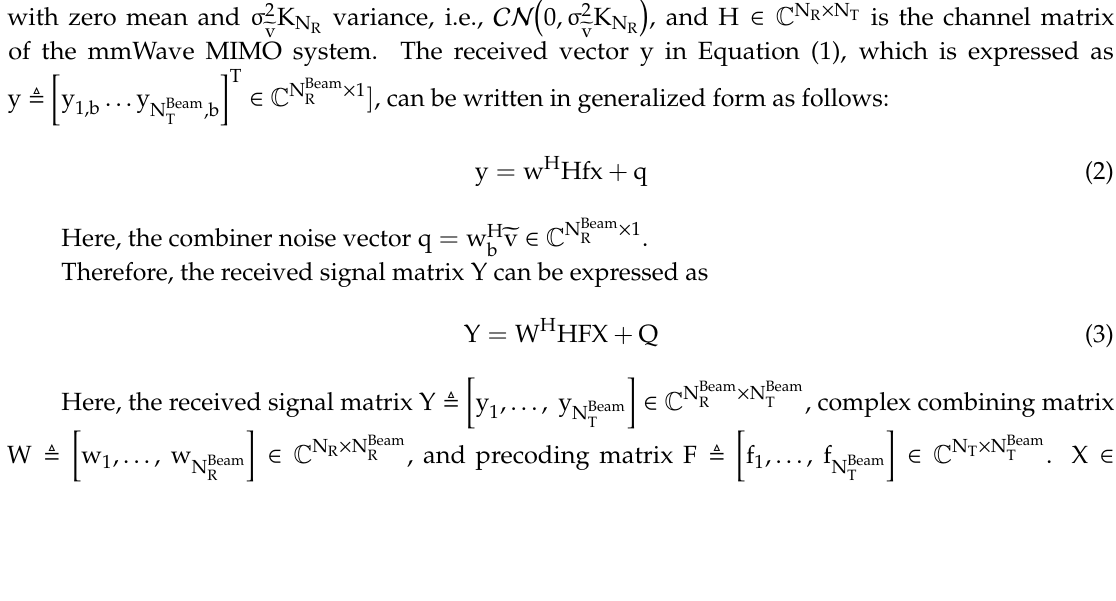
Figure 1. Block structure of a typical mmWave Multiple Input Multiple Output (MIMO) system.